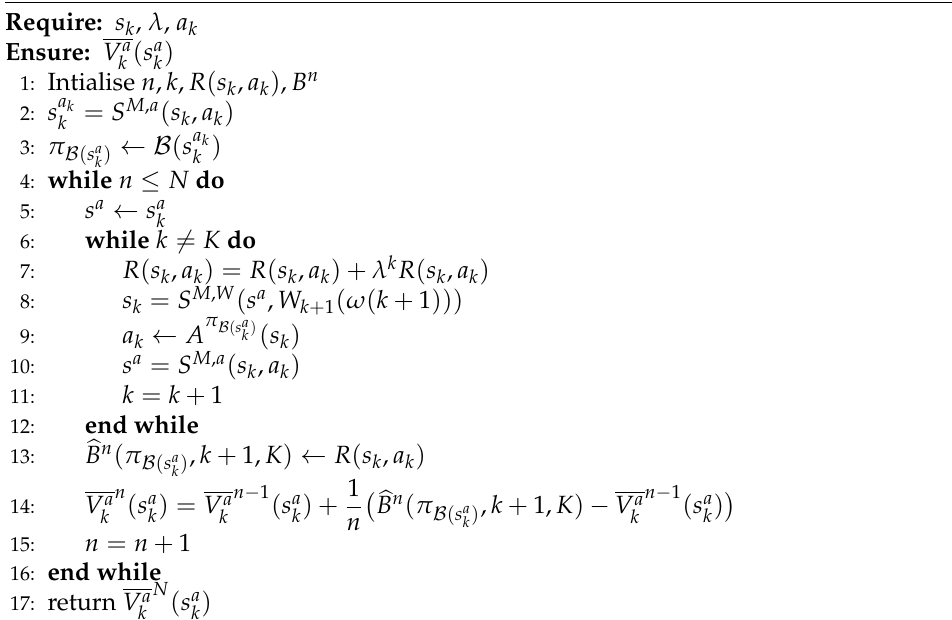
Algorithm 2 Compute V a